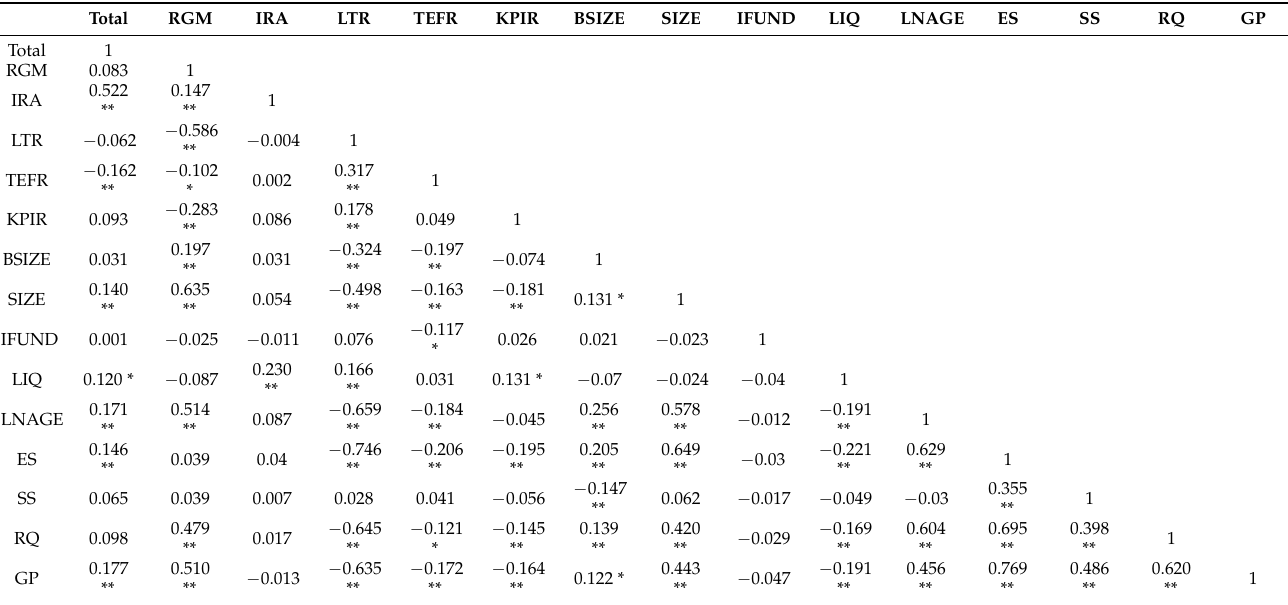
Table 5. Correlation matrix for research variables.